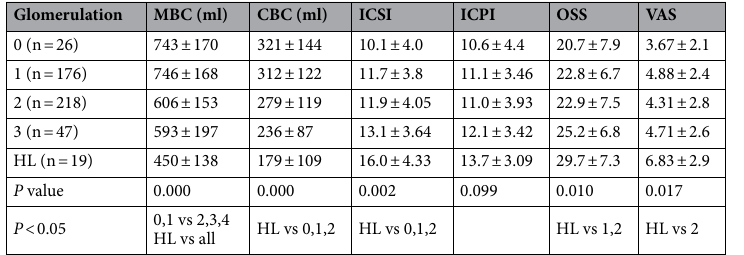
Table 2. Bladder capacity and symptom and pain scores according to the glomerulation grade. The data are presented as mean ± standard deviation. HL, Hunner’s lesions; MBC, maximal bladder capacity; CBC, cystometric bladder capacity; ICSI, Interstitial Cystitis Symptom Index; ICPI, Interstitial Cystitis Problem Index; OSS, O’Leary–Sant Symptom score; VAS, visual analog scale for pain (0–10). Higher urothelial